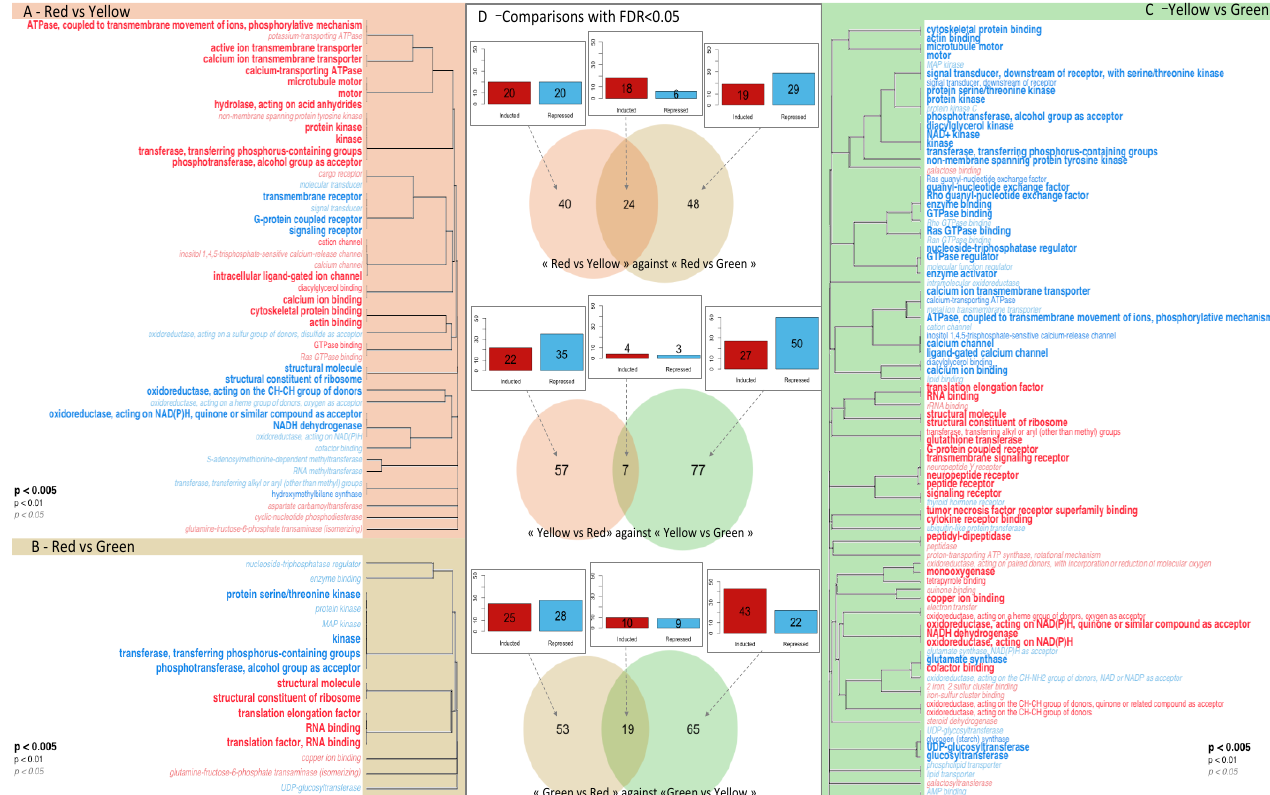
Figure 3. Enrichment analysis and differential expression. ( A – C ), Molecular functions significantly enriched by either over- (in red) or under- (in blue) expressed genes ( A )—the red phenotype compared to the yellow, ( B )—the red phenotype compared to the green, ( C )—the yellow phenotype compared to the green. ( D ) Venn diagrams representing shared and specific genes differentially expressed (FDR < 0.05) between phenotypes. Histograms show the number of over- (red) or under-represented (blue) genes.